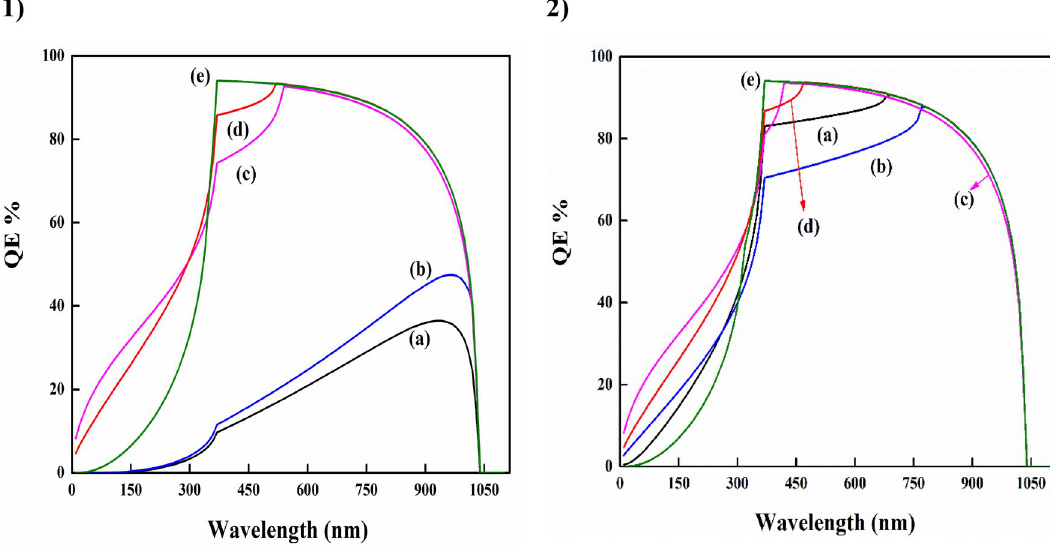
Figure 11. QE% of CIGS solar cells at ( 1 ) Bulk bandgap, ( 2 ) Quantum bandgap for; (a) Ag 2 S. (b) PbS, (c) In 2 S 3 , (d) CdS, and (e) ZnS buffer